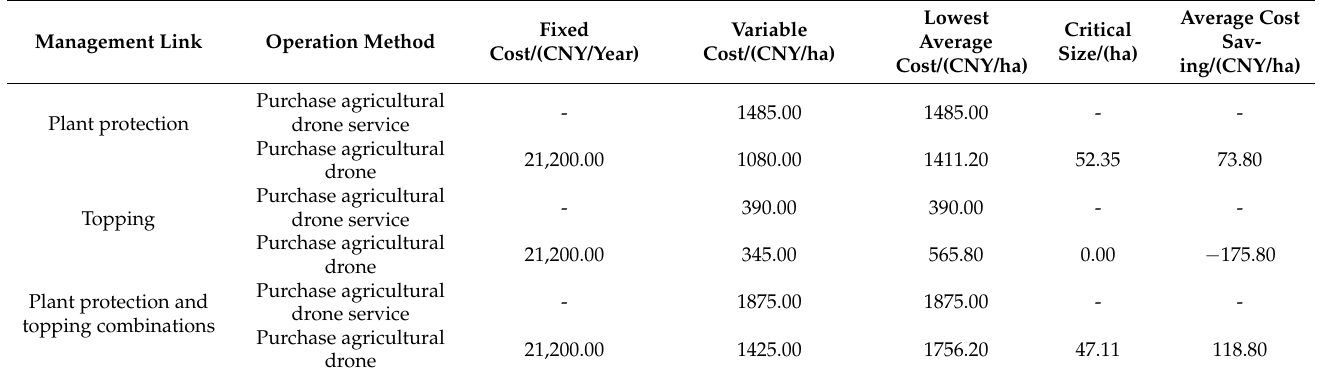
Table 5. The results of the economic evaluation of the purchase of agricultural drone services and the purchase of agricultural drones for the operation of plant protection and